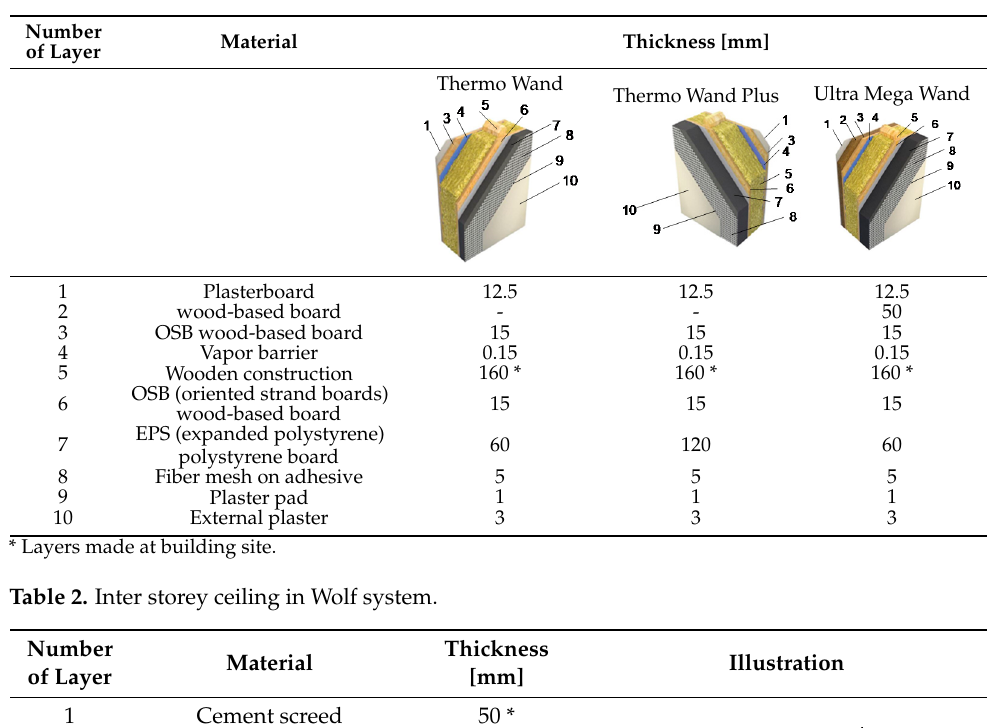
Table 2. Inter storey ceiling in Wolf system.